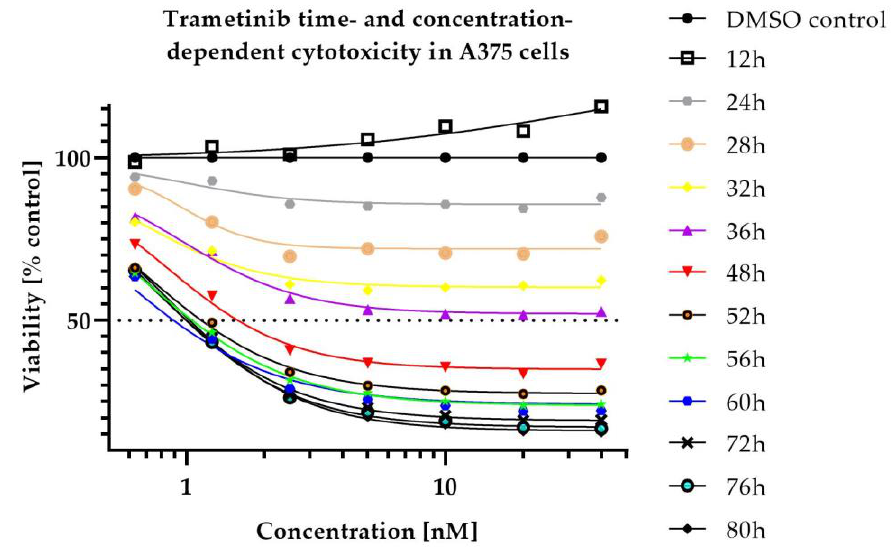
Figure 2. Time and dose-dependent cytotoxicity of Trametinib in A375 cells. Mean from n = 3 (RealTime-Glo assay).